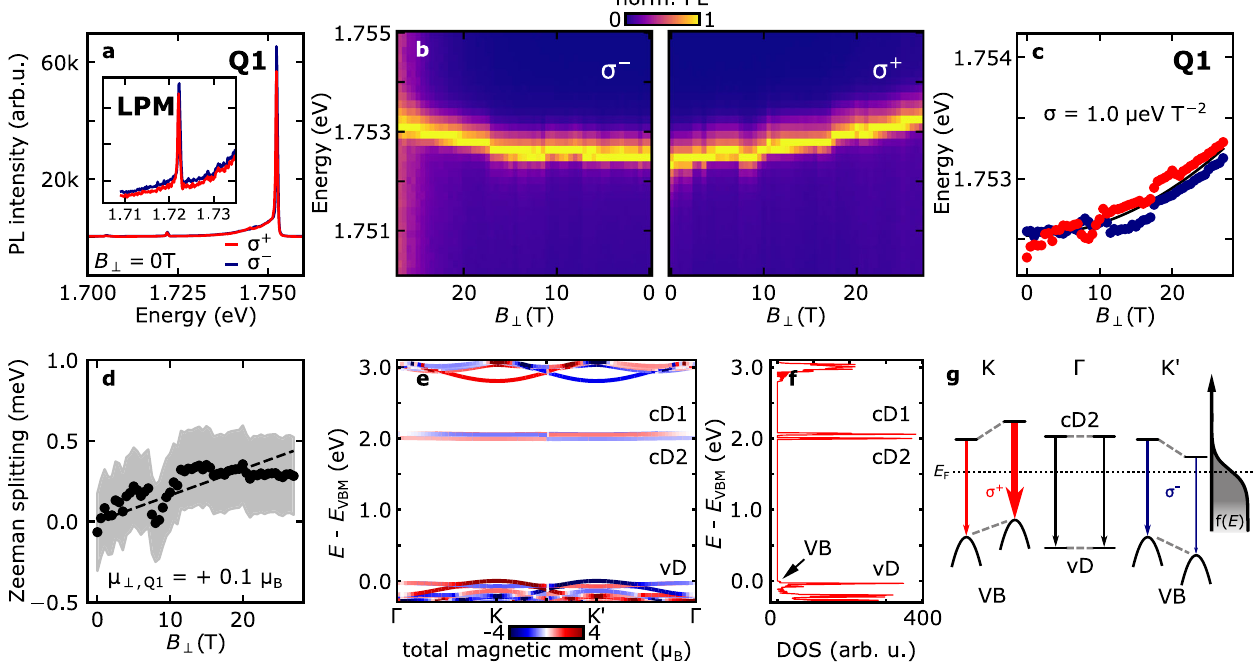
Fig. 2 Out-of-plane magnetic fi eld B ⊥ dependent photoluminescence of defect luminescence Q1. a Low-temperature photoluminescence (PL) spectra of defect luminescence Q1 at zero out-of-plane magnetic fi eld ( B ⊥ ) for σ + (red) and σ − (blue) polarized detection. The zero-phonon line (ZPL) of Q1 occurs at 1.752 eV with a red-shifted (30 meV) local phonon mode (LPM, see inset). b PL versus B ⊥ for Q1. The left (right) panel shows the σ − ( σ + ) polarized signal. The spectra were normalized to their maximum intensity. c The fi tted position of the ZPL of Q1 shows a diamagnetic shift of 1.0 ± 0.1 μ eV T − 2 . d Valley Zeeman splitting of Q1 versus B ⊥ . The black dashed line shows a fi t to the data with a Zeeman splitting of μ ⊥ ,Q1 = + 0.1 ± 0.1 μ B . e Bandstructure of MoS 2 with a periodic sulfur-vacancy extracted from DFT calculations. The color code denotes the total magnetic moment at each k-point. f Density of states (DOS) plot of the Brillouin zone, showing energetically